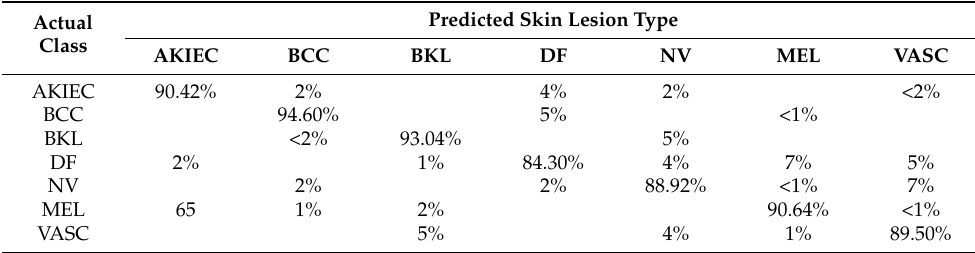
Table 5. Confusion matrix of the KELM for multiple skin lesion type